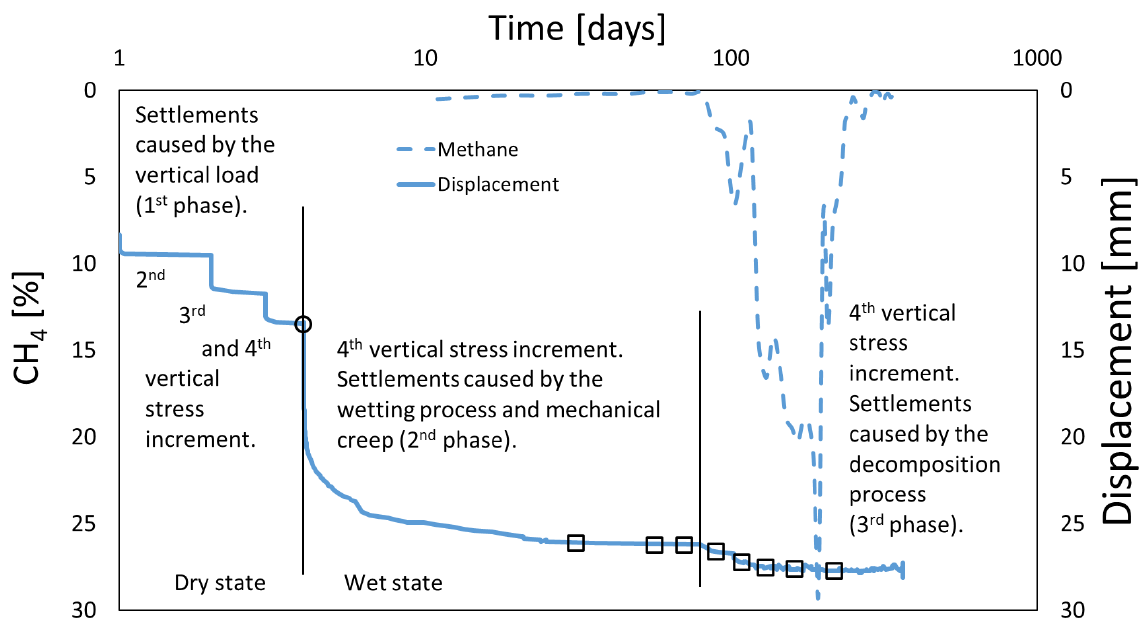
Figure 4. Displacements and methane yield measured in the oedometer test.